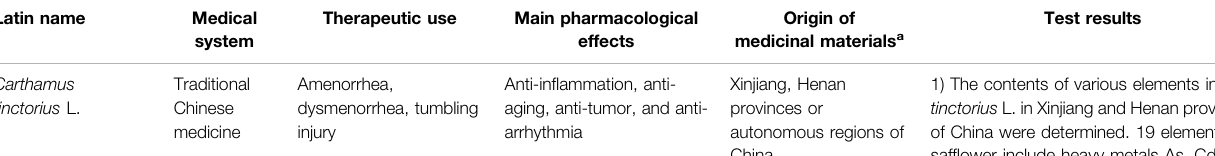
TABLE 4 | Application of ICP-MS in the determination of heavy metal elements in medicinal materials derived from the fl owers of